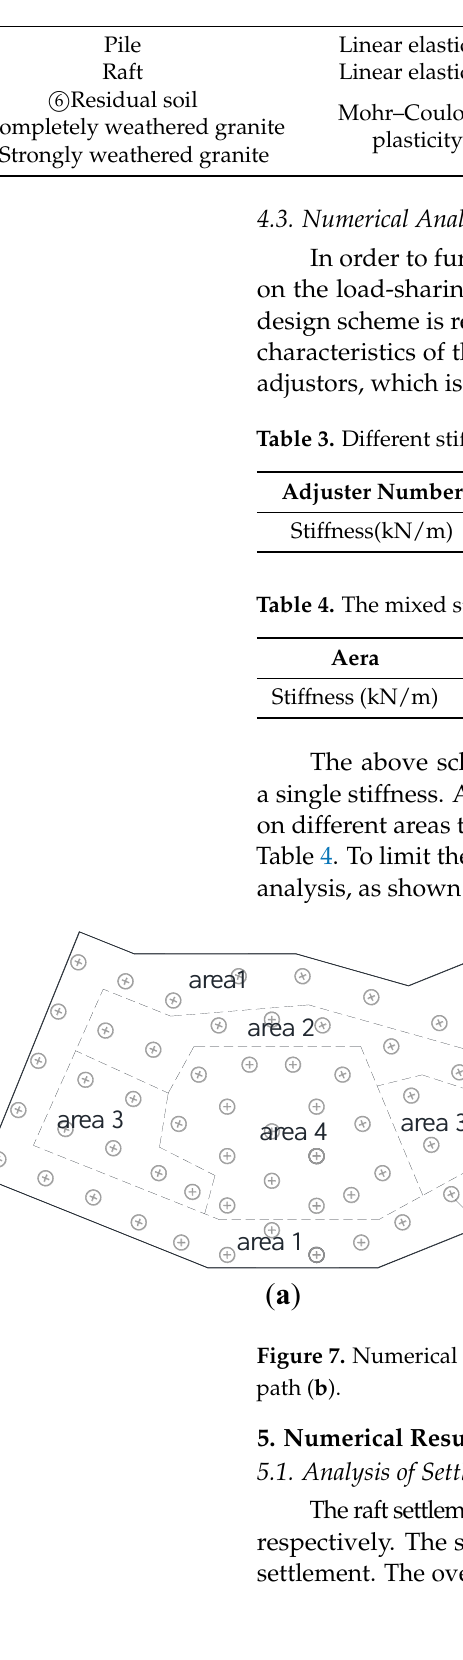
Table 4. The mixed stiffness of deformation adjustor.